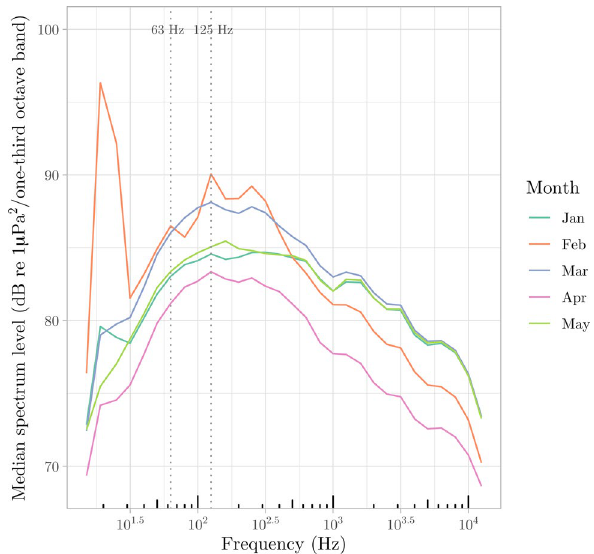
Figure 3. Median power Spectrum Density (PSD) curves for each month, calculated using 1/3 octave band measurements every 30 s. The vertical dotted lines indicate the 63 and 125 Hz centered 1/3 octave bands. Note that all values remain below the 100 dB threshold defined by Erbe